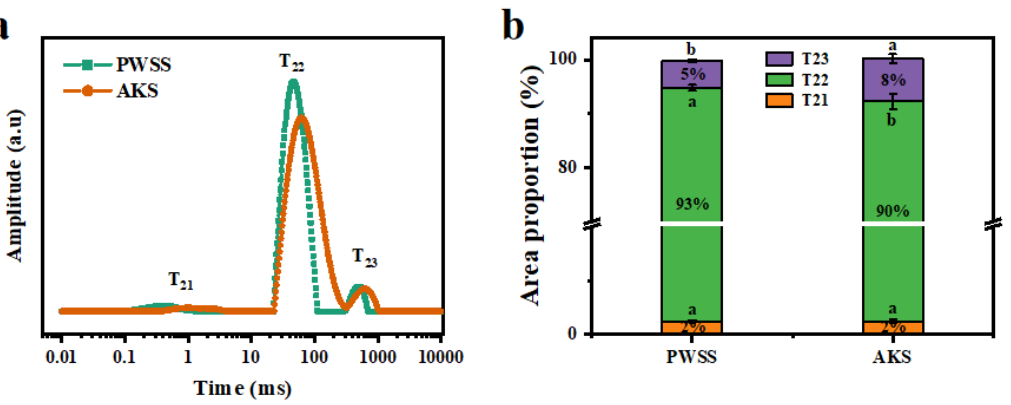
Figure 3. Nuclear magnetic resonance spin–spin relaxation (T 2 ) of Antarctic krill and Pacific white shrimp surimi gels: ( a ) The curve of T 2 relaxation time, and ( b ) the percentage of T 21 , T 22 , and T 23 . PWSS, Pacific white shrimp surimi; and AKS, Antarctic krill surimi. Different letters (a–d) within the same sample indicate significant differences ( p < 0.05).